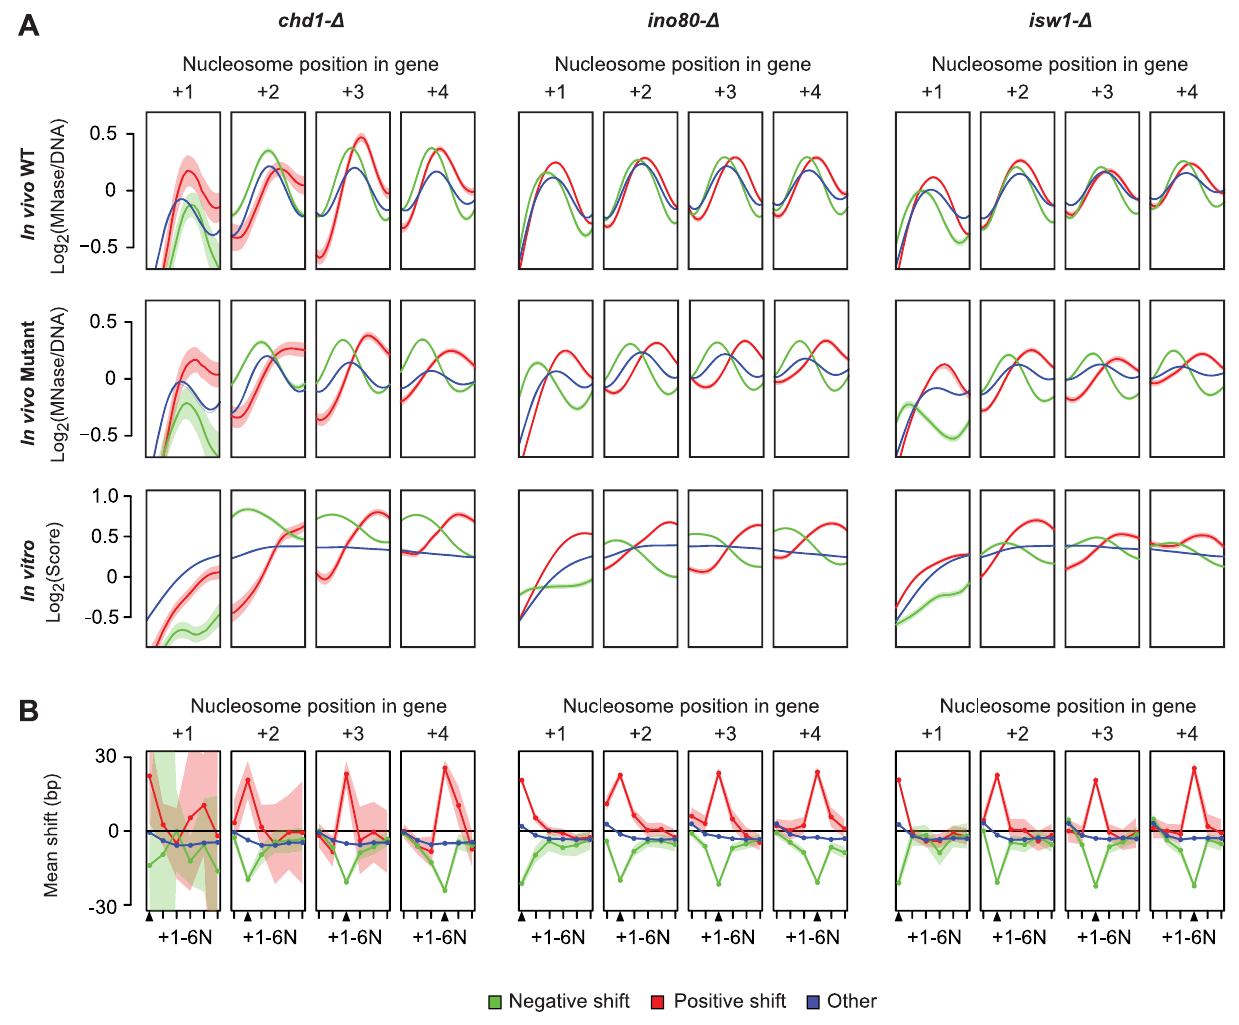
Figure 4. Nucleosomes disrupted in remodeler ATPase mutants are in more intrinsically preferred positions. A) WT (top row) and Chd1, Ino80 and Isw1 deletion mutant (middle row) occupancy profiles at genic nucleosome positions are shown in comparison to occupancy profiles ( in vitro occupancy) based on intrinsic sequence preferences obtained from Kaplan et al. [27] (bottom row). Each panel corresponds to a genic nucleosome position, numbered relative to the TSS, and plots the in vivo or predicted occupancy for genes with a positive (red), negative (green), or no shift (blue) in nucleosomes at that position. Solid lines reflect the mean occupancy in a smoothing window with a bandwidth of 25 bp, with the corresponding 95% confidence interval indicated by shaded areas of the same color. B) Overview of the effects of nucleosome shifts at each + 1 to + 4 position on neighboring nucleosomes in the same genic array. Each panel shows the average shift profile (solid lines) and 95% confidence interval (shaded area) for all nucleosomes in the same array for genes with a positive (red), negative (green) or no shifts (blue) at the indicated genic nucleosome position (black triangle).